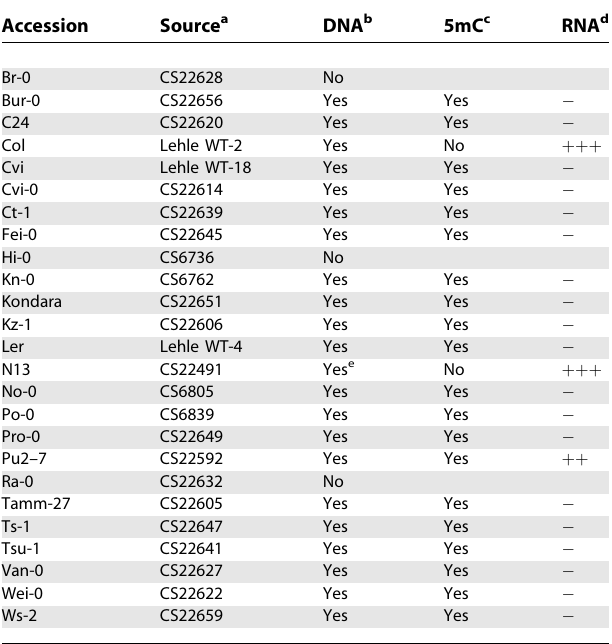
Table 1. Natural Variation of At2g10410 Structure, Cytosine Methylation, and Expression